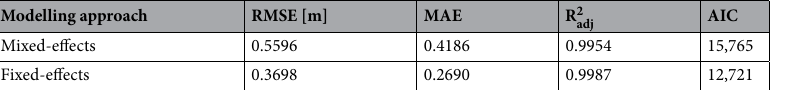
Table 7. Characterisation of the fit statistics of the regional models developed using mixed-effects and fixed- effects modelling approaches.